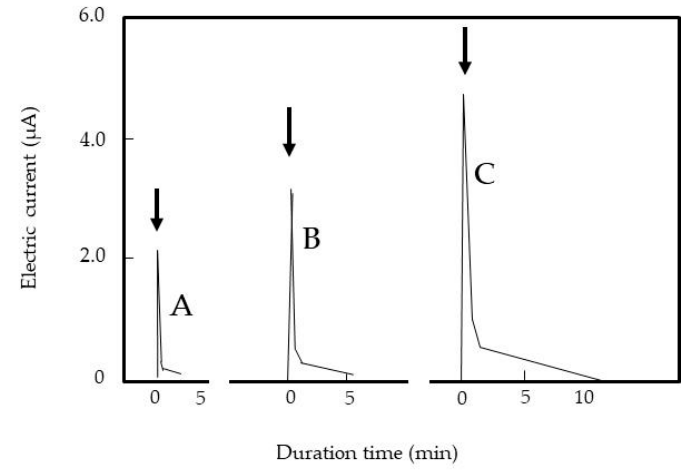
Figure 4. Transient electric currents from discharges of adult houseflies when the insulated plate of the SEP has a charge of (A) –6.5, (B) –7.0, and (C) –7.5 kV. Arrow indicates when insect was placed on grounded plate.